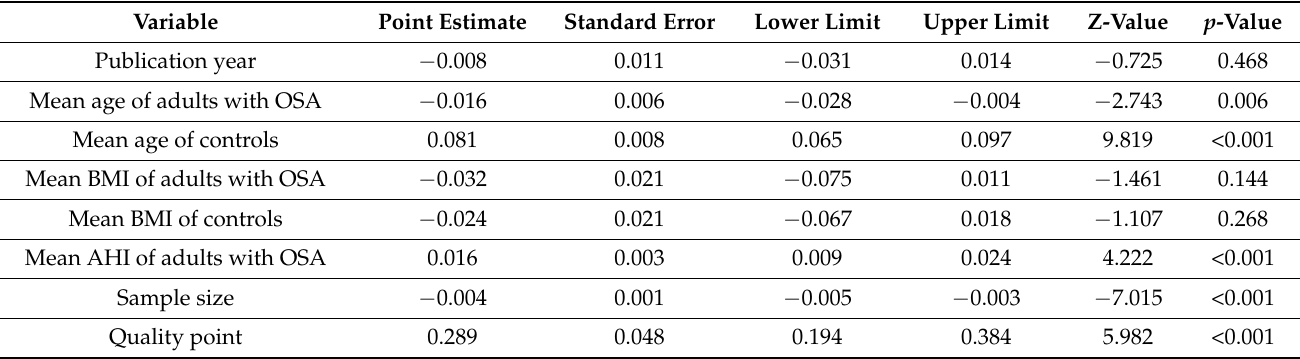
Table 5. Fixed-effects meta-regression analysis. Intercellular adhesion molecule-1 levels in adults with obstructive sleep apnea compared to controls.